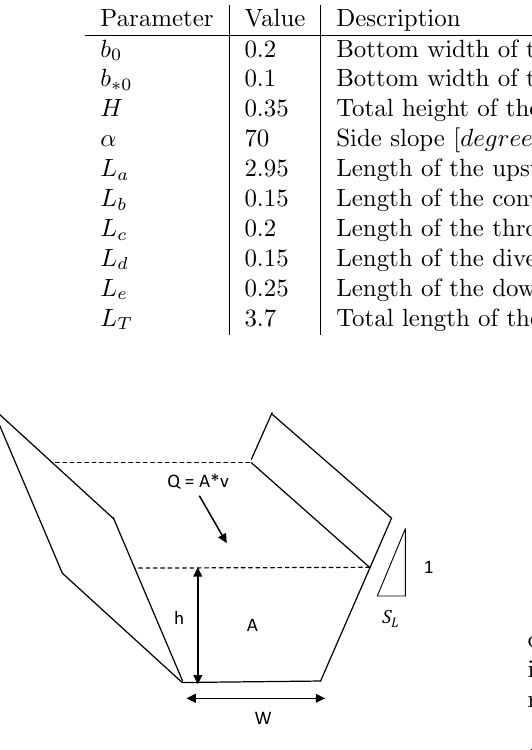
Table 1: Venturi flume dimensions